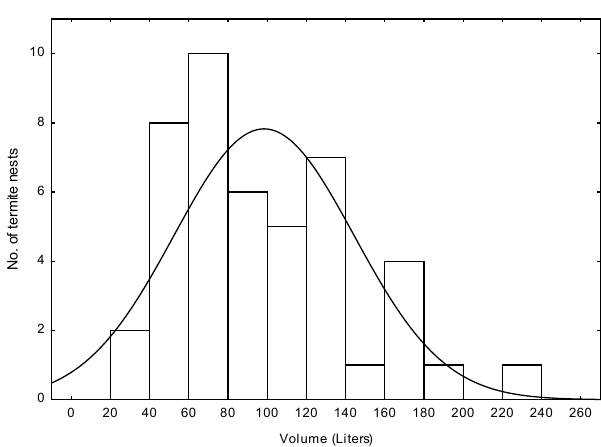
Fig 2 . Frequency distribution of the number of termite nests inhabited by bee colonies by volume (Liters). The line shows the observed normal distribution of the size of large termite nests occupied by bee colonies (Kolmogorov-Smirnov d=0.09902, Chi-Square=3.53640, df=3, p=0.31607,